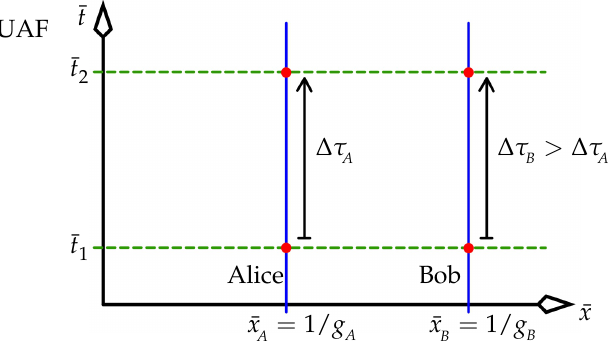
Figure 7. The scenario of Figure 4 shown in the UAF’s barred coordinates. Analysing the rate of flow of time consists of finding and comparing the proper time intervals ∆ τ , ∆ τ that correspond to a single lapse of coordinate time ¯ t A B in (29), repeated in